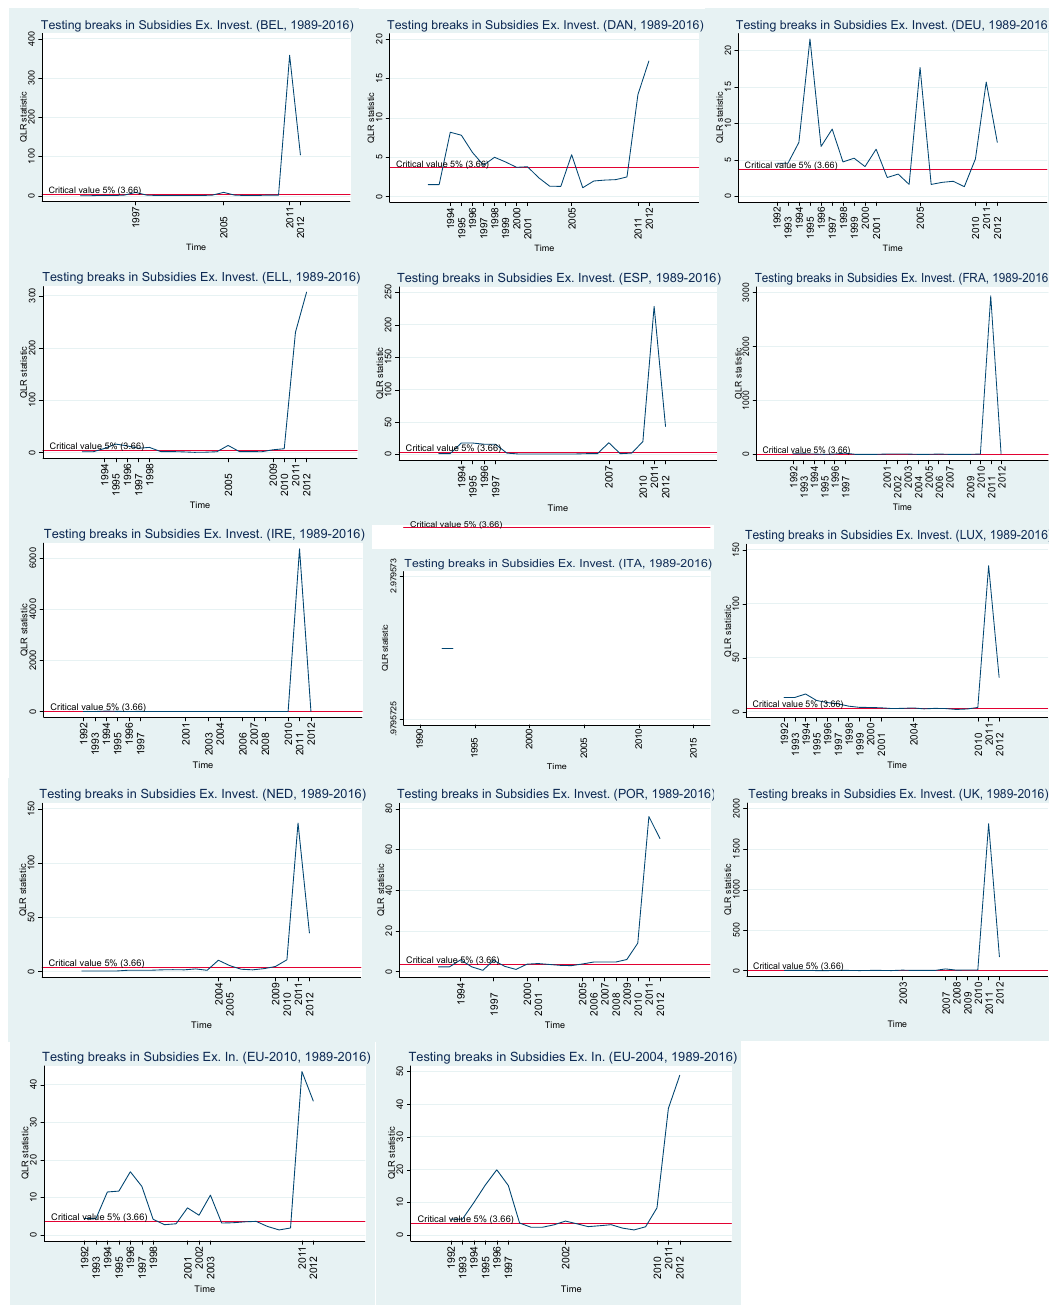
Figure 11. Testing for breaks in total subsidies—excluding on investments (euros) over the European Union countries (1989—2016).